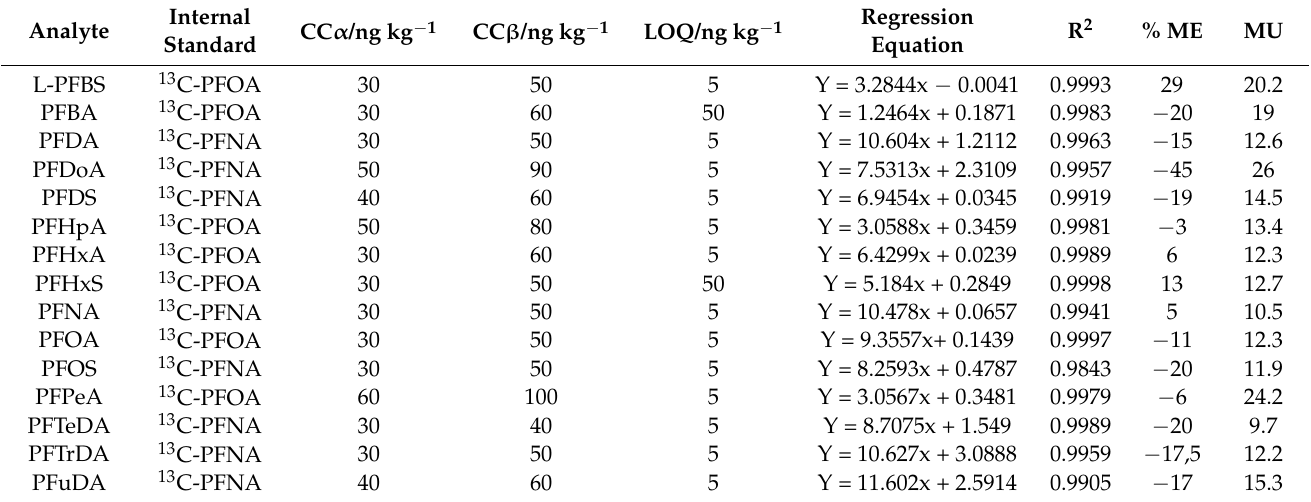
Table 1. Analytical validation parameters for PFAS in matrices.